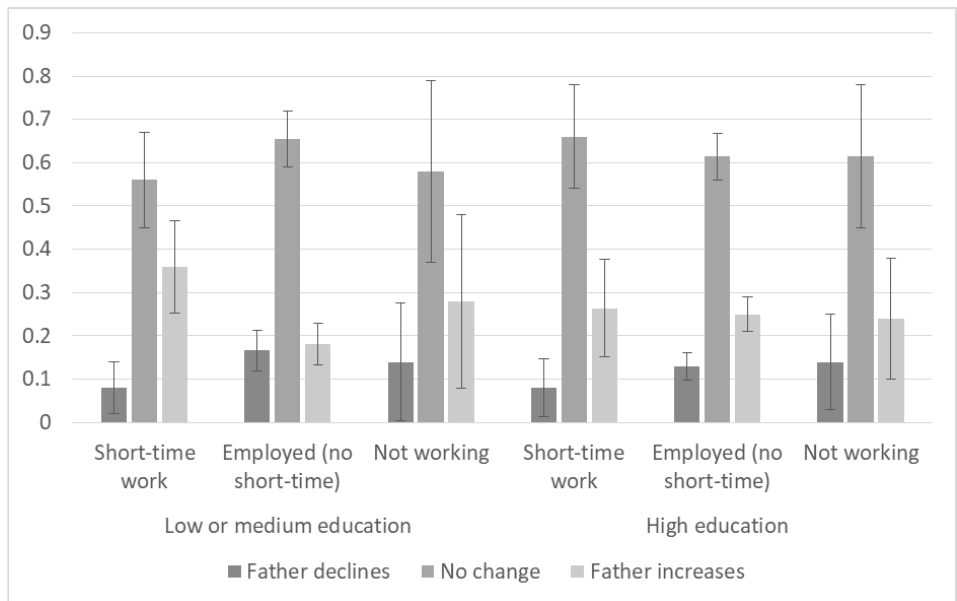
Figure 3 : Average predicted probabilities from multinomial regression model separated by educational status, male